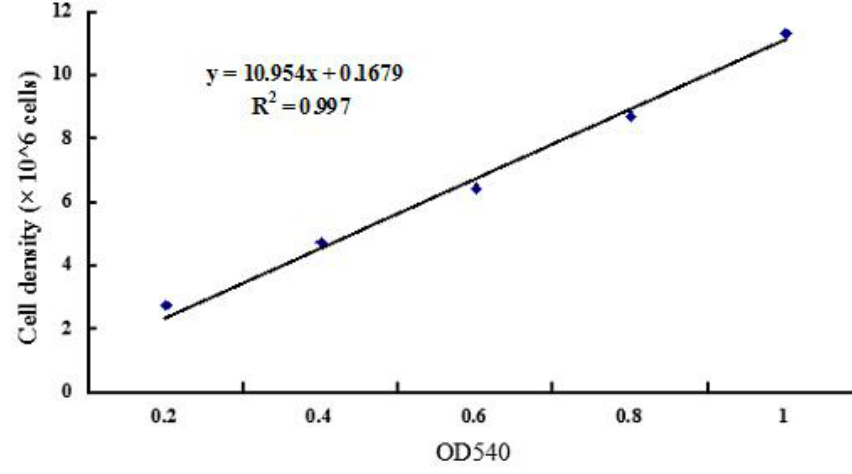
Figure 1. The calibration curve between OD540 and cell density.